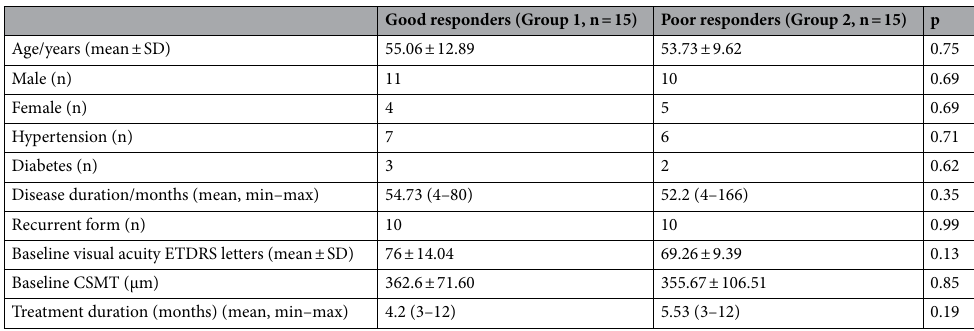
Table 2. Baseline, disease, and treatment characteristics of the two groups. Independent samples student’s t-test and chi-squared test were applied for group comparisons.